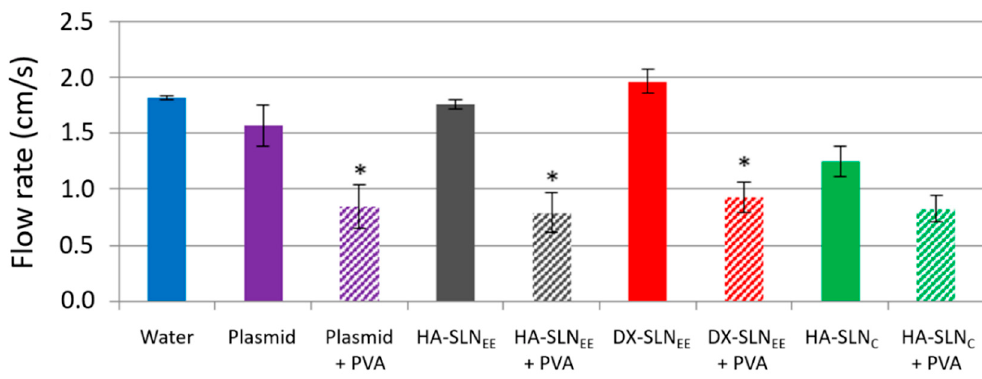
Figure 1. Flow rates of water, plasmid solution, SLNs, and vectors with and without PVA (expressed as cm / s). * p < 0.05 with respect to the same formulation without PVA. PVA: polyvinyl alcohol; HA: hyaluronic acid; DX: dextran; SLN: solid lipid nanoparticle.